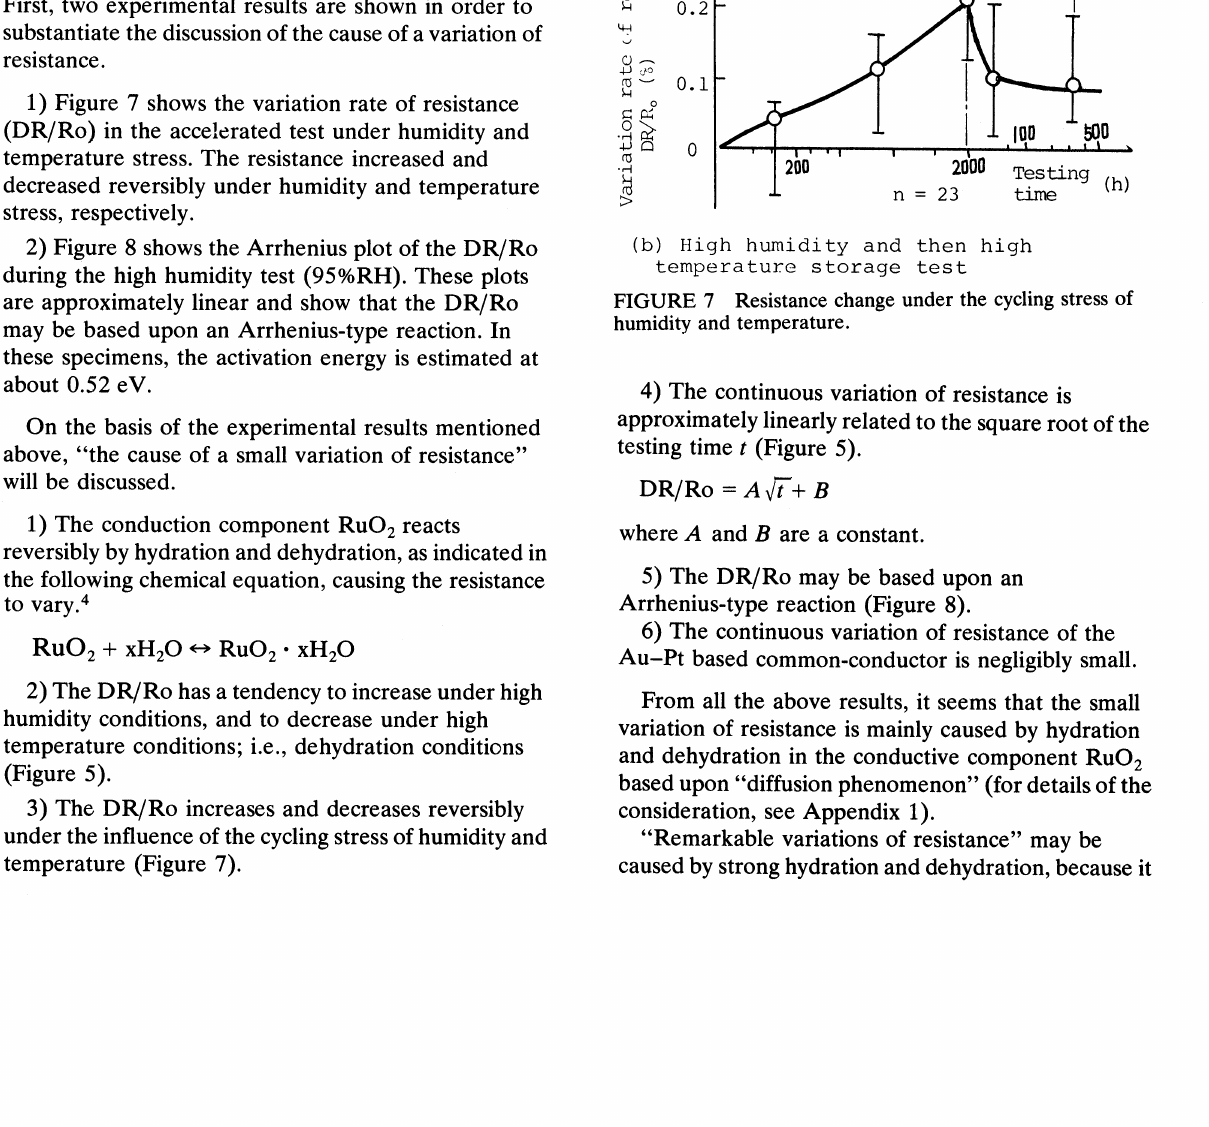
FIGURE 7 Resistance change under the cycling stress of humidity and